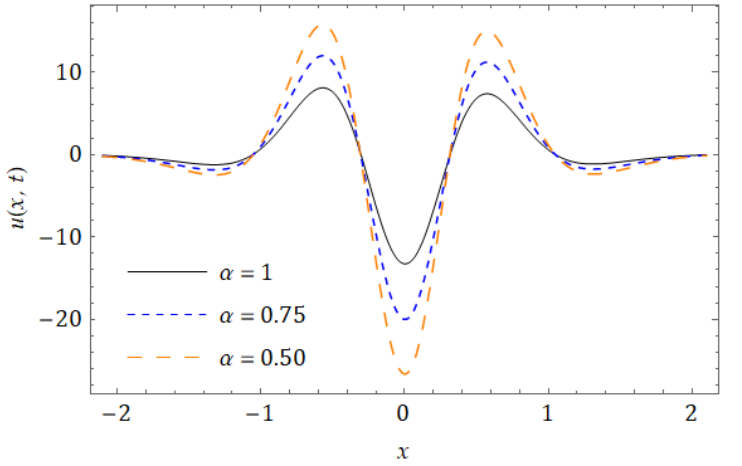
Figure 6. Response of the obtained solution with distinct 𝛼 and time at 𝑛 = 1, 𝑡 = 0.5, ℏ = −1,𝛽 = 1, 𝜅 1 = 𝜅 2 = 1 and 𝜌 = 0.001 for Case II.